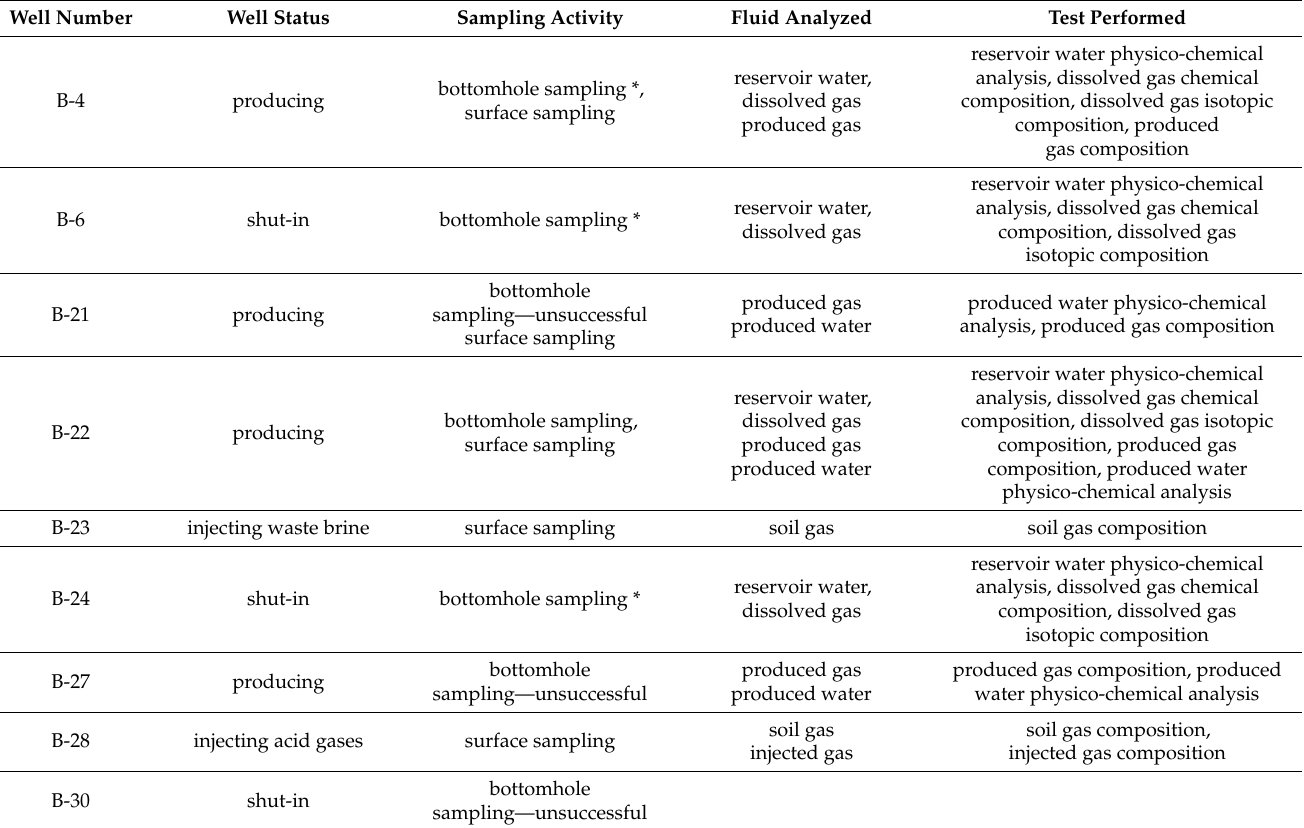
Table 3. Sampling and testing